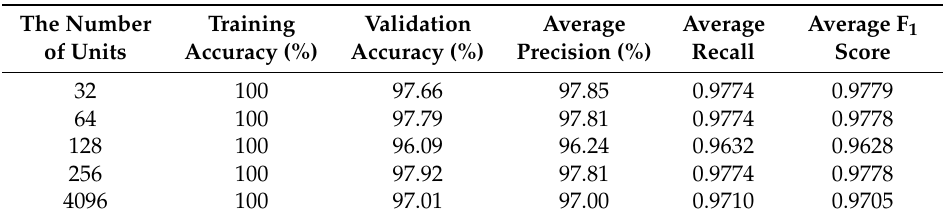
Table 3. Experimental results with different units in the fully connected layers of the ship classification model based on VGG16.